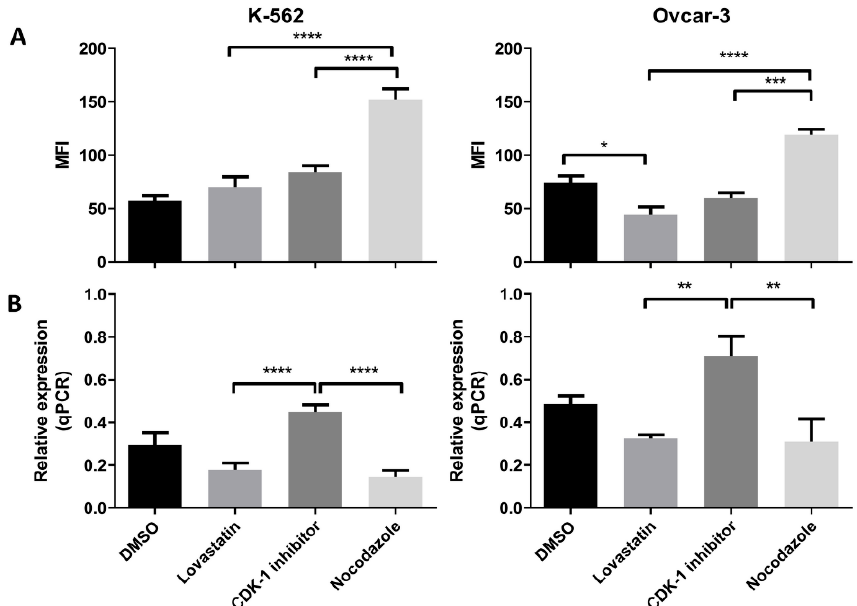
Figure 5. PD-L1 (protein and mRNA) expression in K-562 and OVCAR-3. ( A ). MFI using mode fluorescence intensity is shown for the two cell lines. Both the cell lines showed significant increase in PD-L1 protein expression in the cells treated with nocodazole (mitotic), no difference was observed between lovastatin- (G1) and CDK-1 inhibitor (G2)-treated cells. ( B ). Similar gene expression to HLA-G was found for PD-L1 where G2 phase cells had higher gene expression compared to cells treated with lovastatin (G1) and nocodazole (mitotic), while there was no difference found in the gene expression between cells treated with lovastatin (G1) and nocodazole (Mitotic). (One-Way ANOVA; Tukey’s test * < 0.05, ** < 0.005, *** < 0.001, **** < 0.0001).